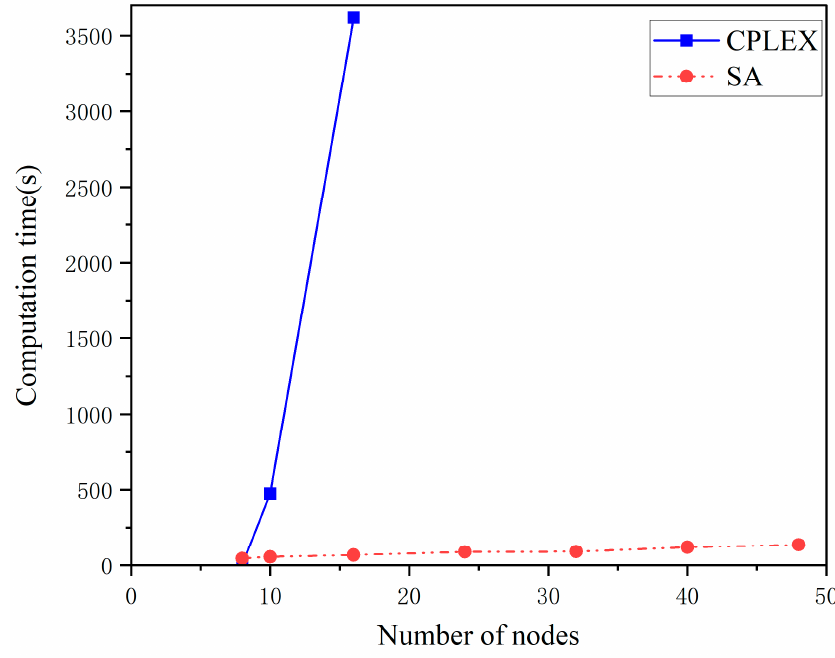
Figure 2. Average computation times with CPLEX and SA. Figure 3 provides graphic representations of the convergence of the solutions for the problem instance with 18 nodes. For the identical problem instance, the graph depicts the convergence of the SA, PSO, and GA algorithms. It is obvious from the figure that PSO and GA become stuck in local optima, since it converges early for all problem situations. Because SA extensively searches the search space with the aid of an acceptance-probability strategy to allow subpar solutions, it takes more iterations to settle to a near-optimal solution. Therefore, the developed SA algorithm is effective in solving the model proposed in this paper.